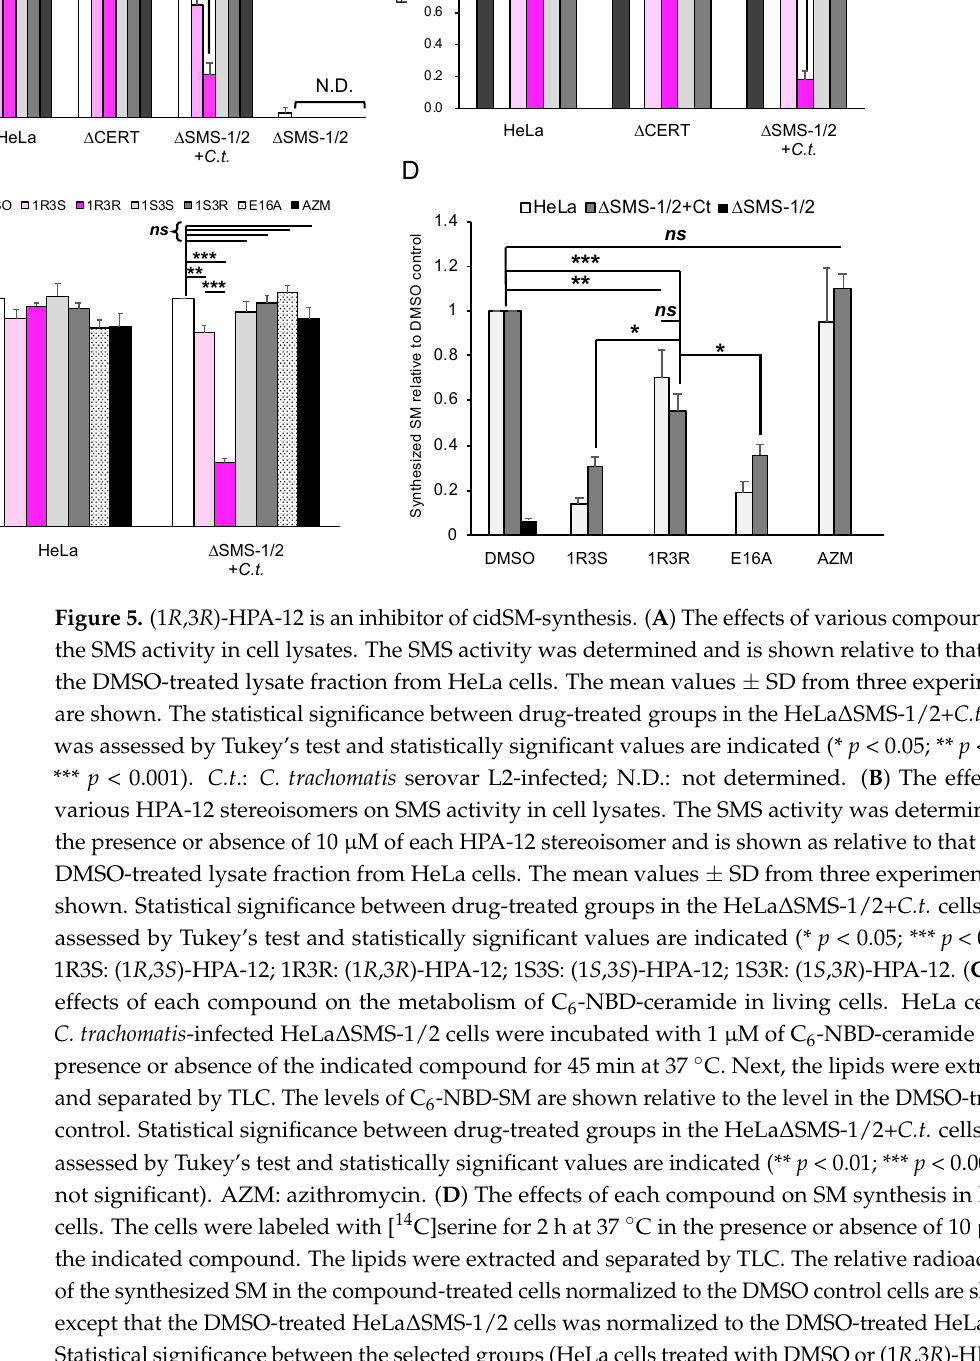
HPA-12 and E16A (Figure 5D). Collectively, these results indicated that (1 R ,3 R )-HPA-12 mildly represses the de novo SM synthesis via the cidSM-synthesis pathway.